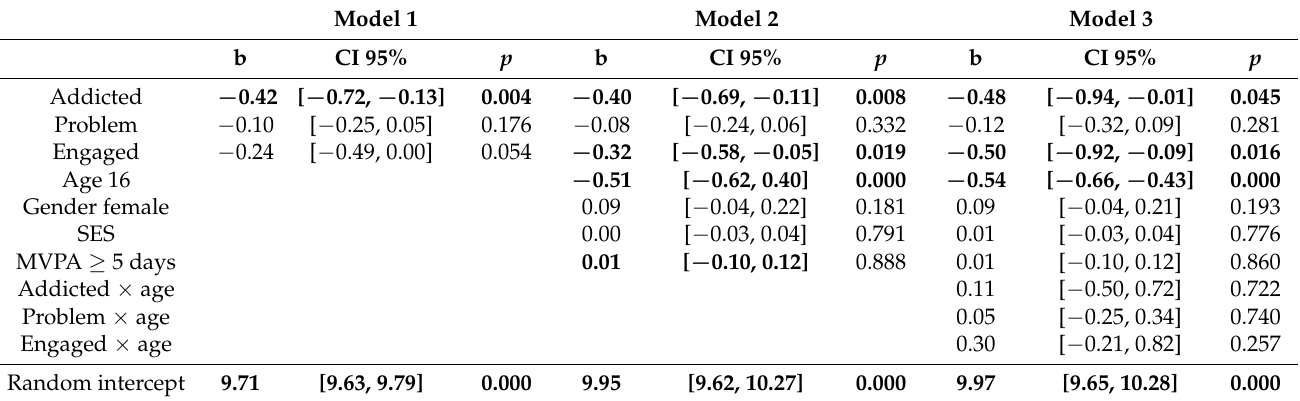
Table 3. Crude and adjusted associations of gaming behavior and sleep duration on weekends. Model